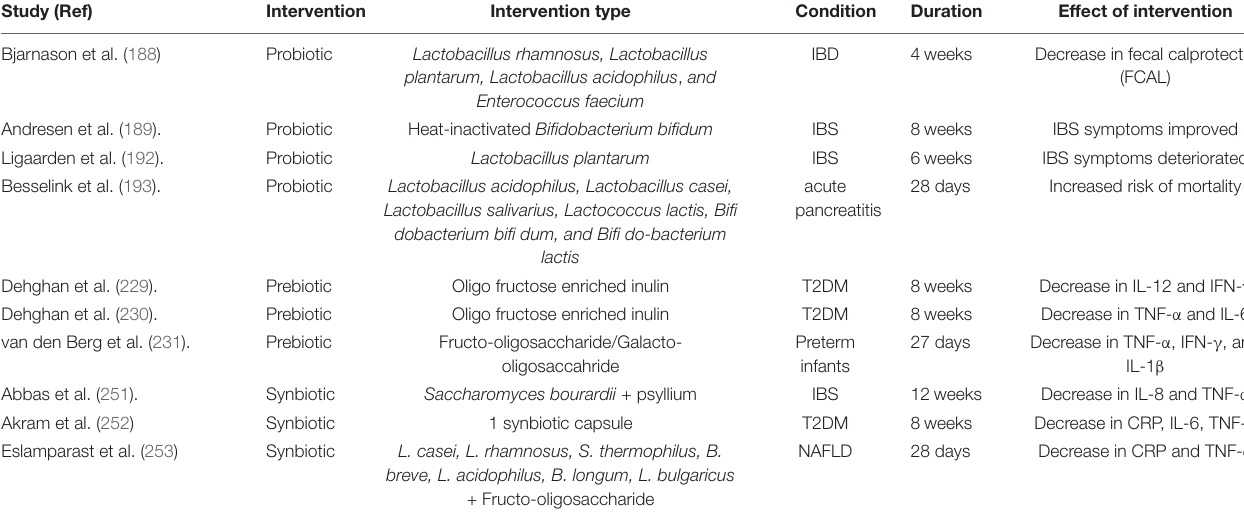
TABLE 1 | Important clinical trials showing effects of prebiotics, probiotics and synbiotics on inflammatory conditions. Study (Ref)